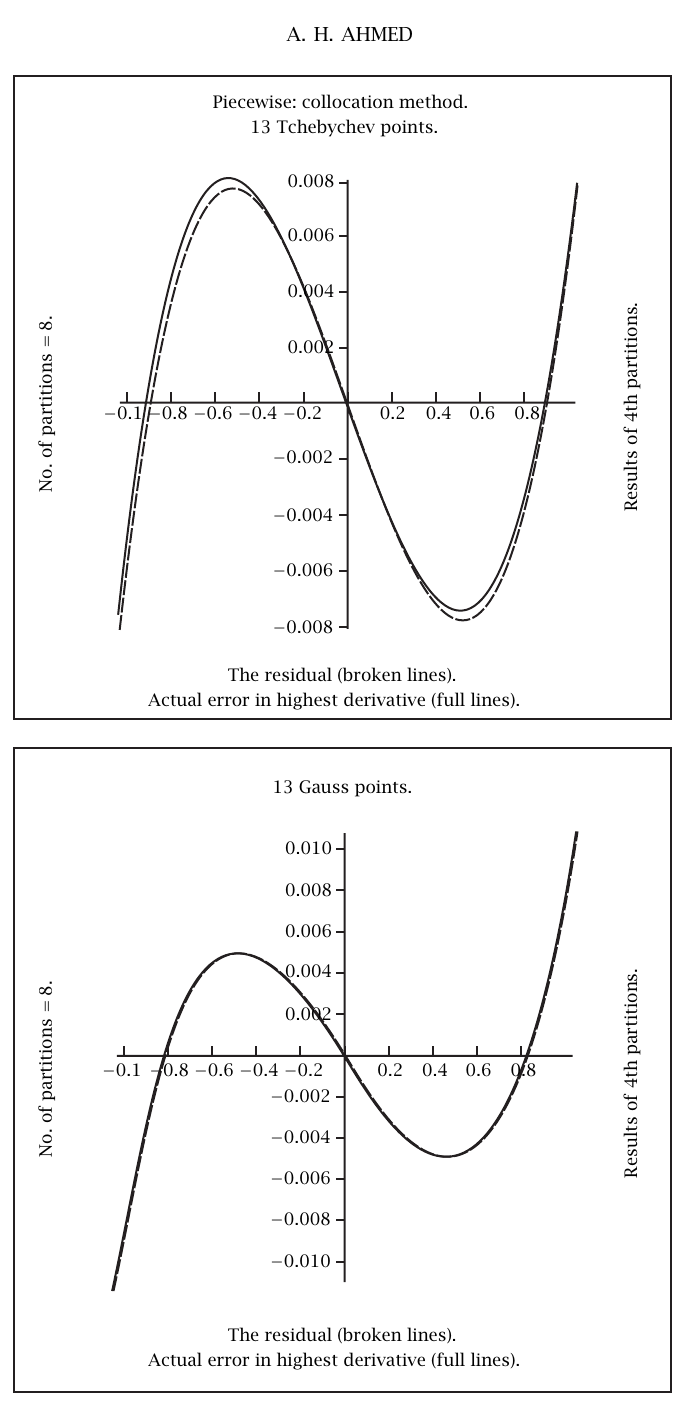
The residual (broken lines). Actual error in highest derivative (full lines). Figure 4.2